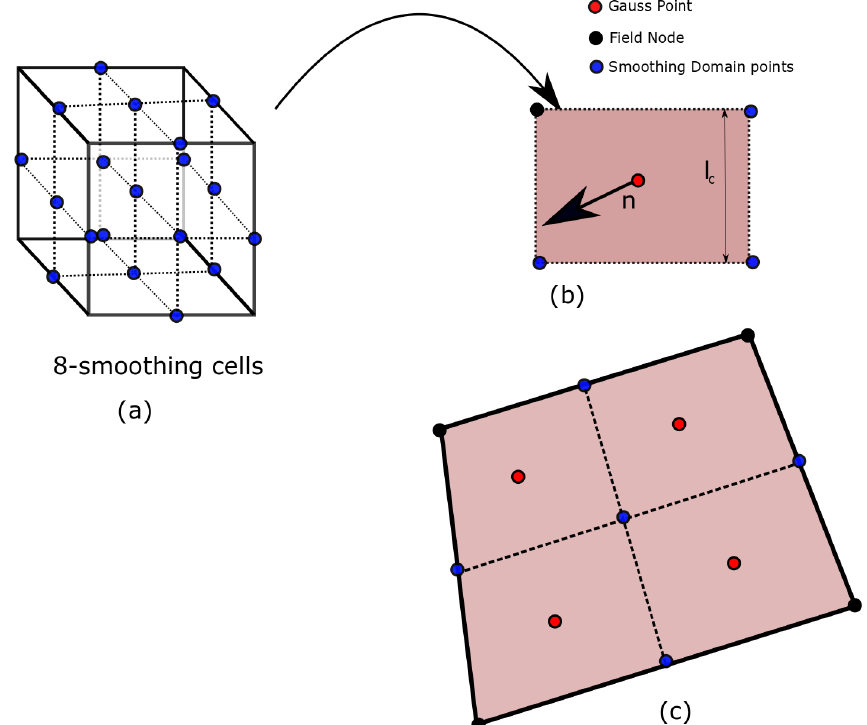
Figure 2. A 3D H8 element subdivided into eight smoothing cells: ( a ) subdivision into smoothing cells by joining the midpoints of the edges and the faces; ( b ) face area of a smoothing cell with its outward normal and length; and ( c ) entire face of the element containing surfaces of the four smoothing